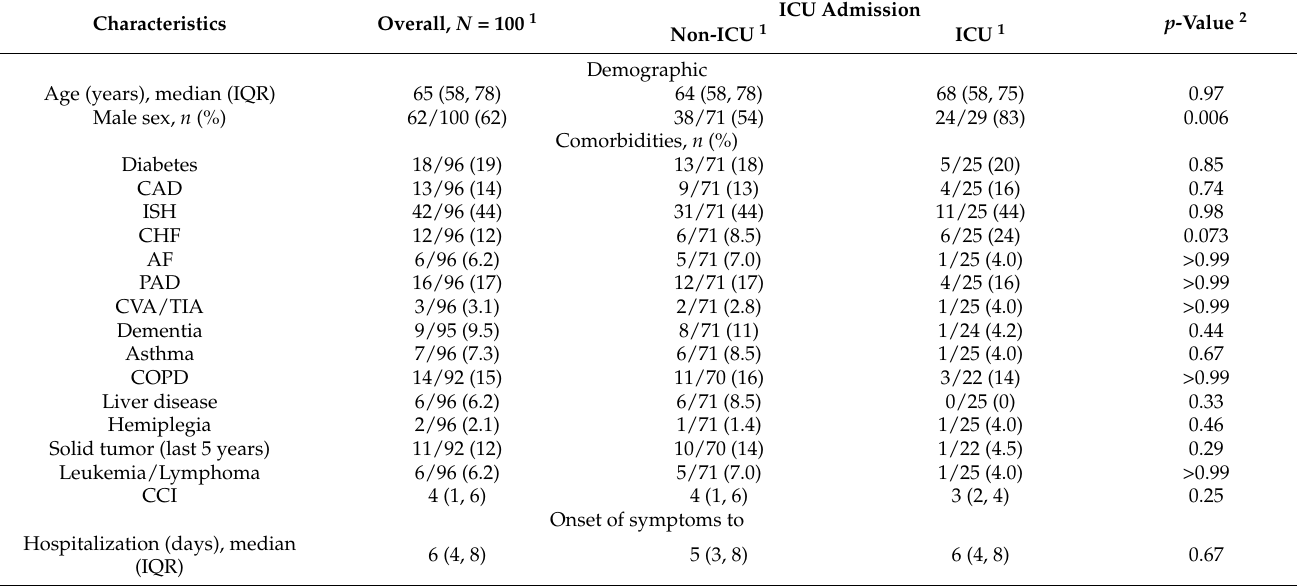
Table 1. Patient